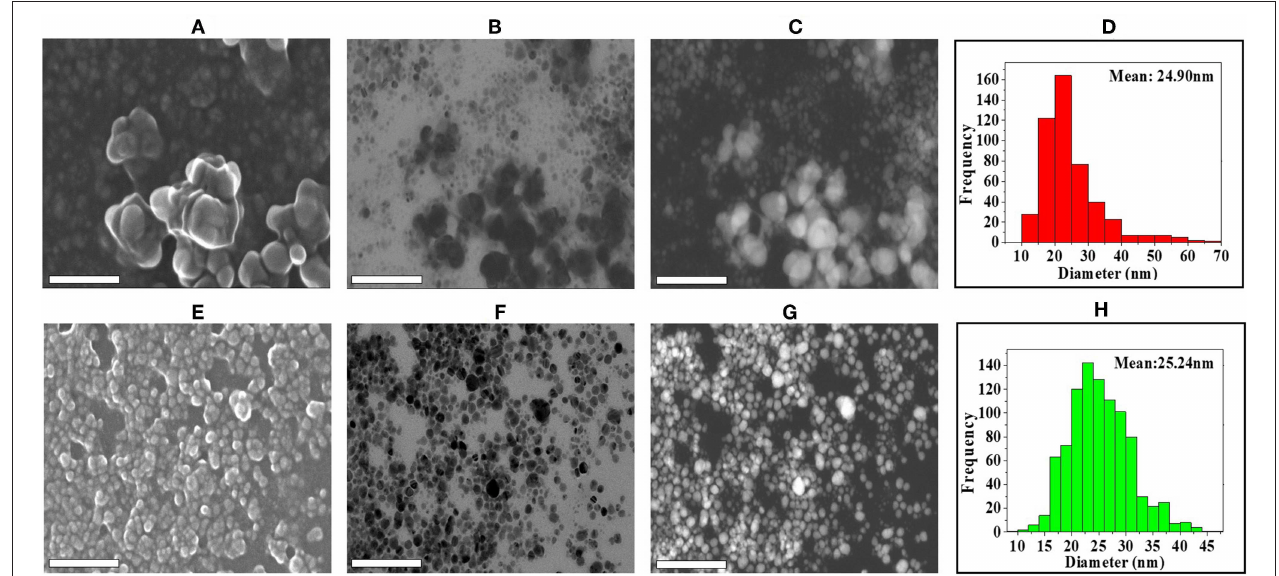
FIGURE 2 | Analysis of the shape, morphology, and size of biogenic Ag nanoparticles (bAgNPs) with scanning transmission electron microscope (STEM). SE images show the formation of Aq-bAgNPs (A) . Scanning TEM images (B) , high-angle annular dark-field (HAADF) images (Z-contrast images) (C) , and histogram for particle size distribution (D) show the formation, spherical shape, and size of Aq-bAgNPs. Similarly, SE (E) , scanning TEM (F) , HAADF images (G) , and histogram for particle size distribution (H) show the formation spherical shape and size of Et-bAgNPs. Scale bar: 200nm.